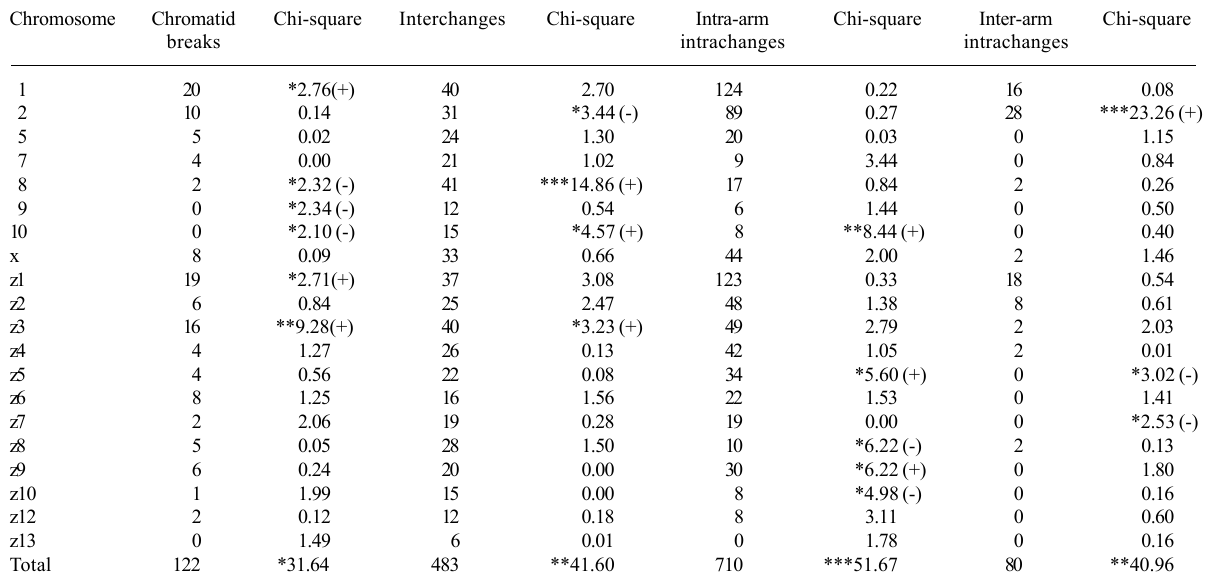
Table III - Interchromosomal distribution of radiation-induced breakpoints involved in chromatid breaks, interchanges and intrachanges in CHO cells. Chromosome